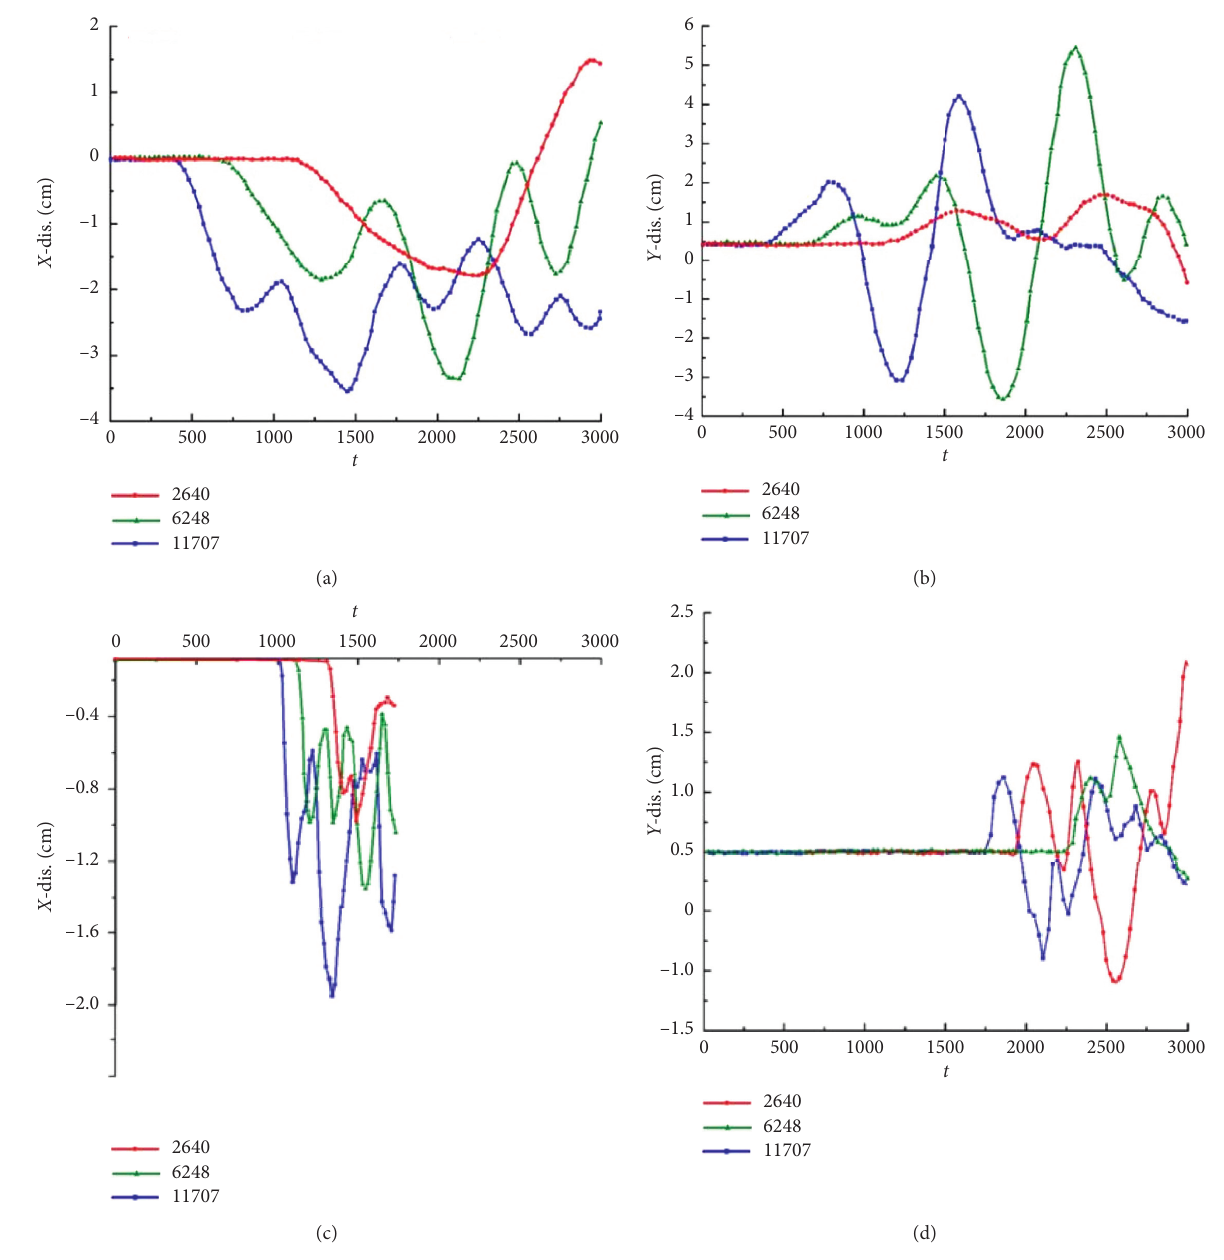
Figure 10: Displacement–time history curves of different monitoring points. (a) Model 1, x -direction. (b) Model 1, y -direction. (c) Model 2,